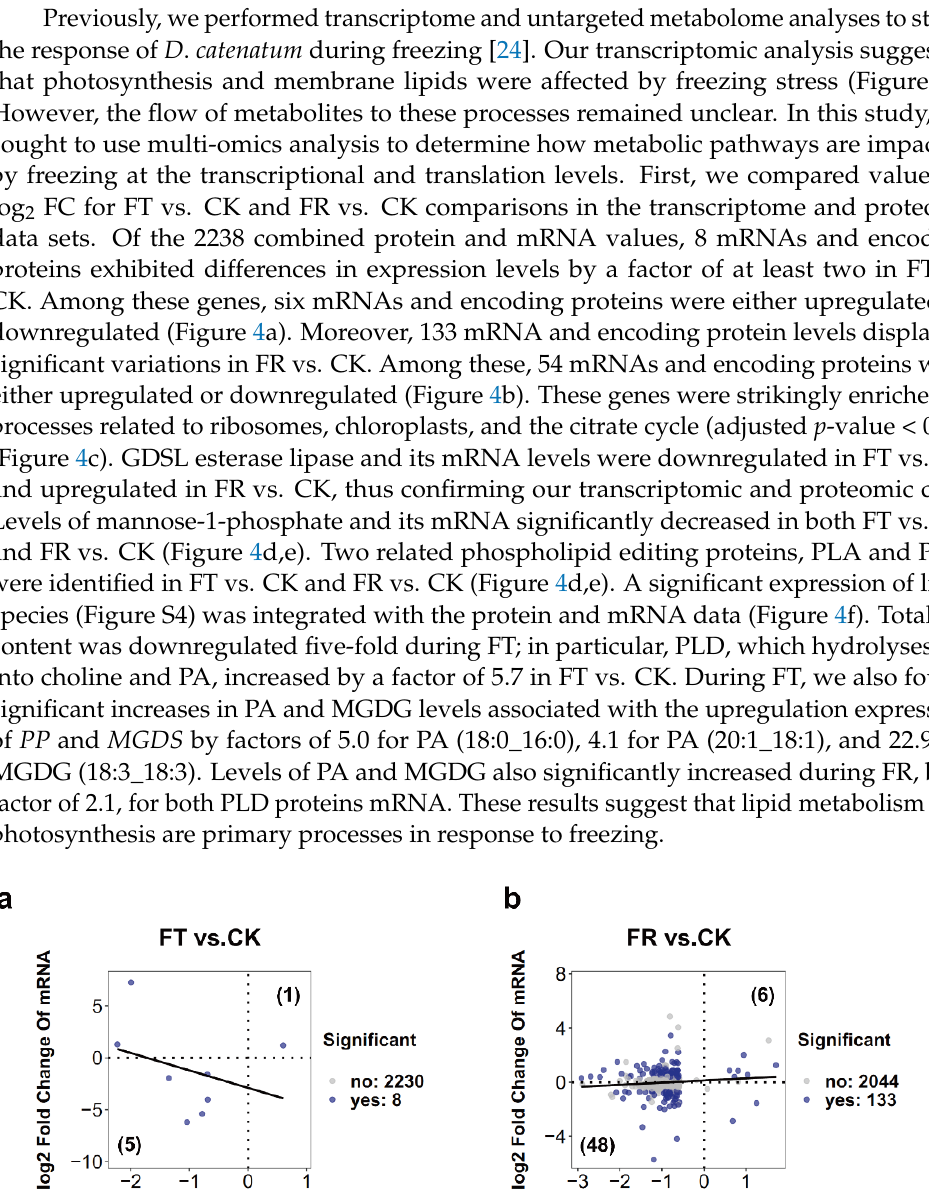
Figure 4. Integrated analysis of multi-omics during freezing stress. ( a ) Scatter plot showing the re- lationship between changes in protein and mRNA abundances in FT vs. CK. ( b ) Scatter plot showing